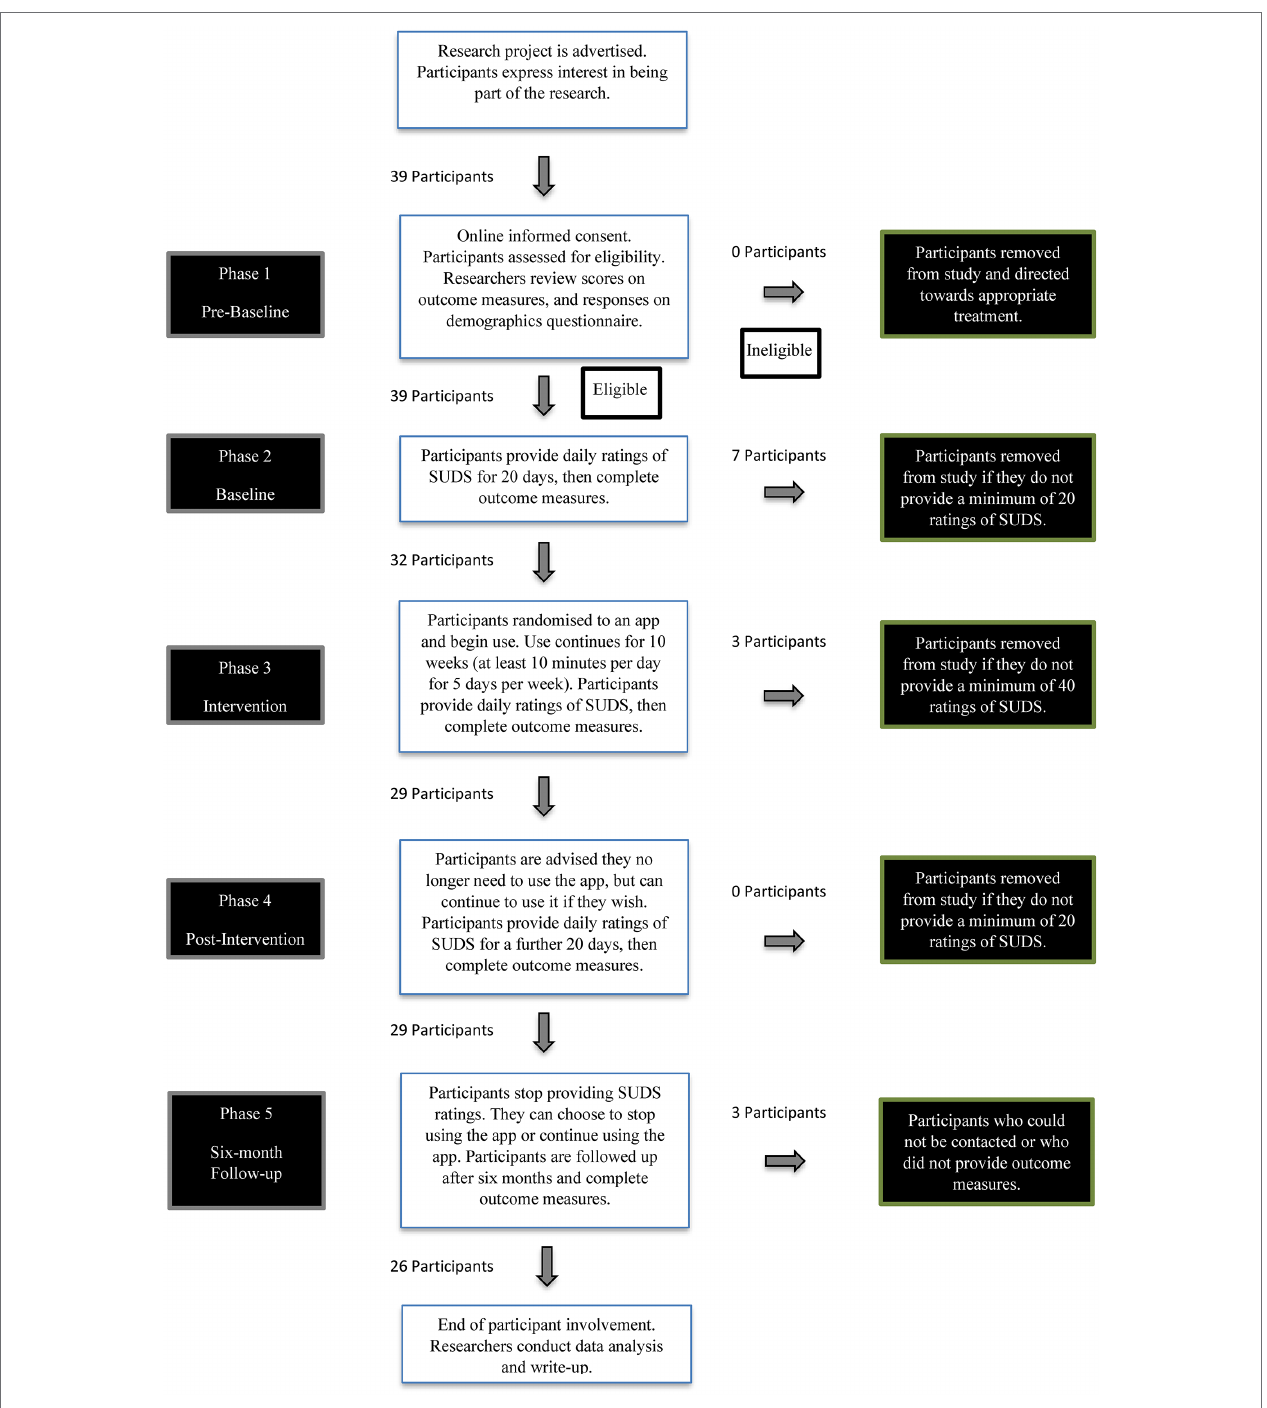
FIGURE 1 | Flowchart of participant involvement and study